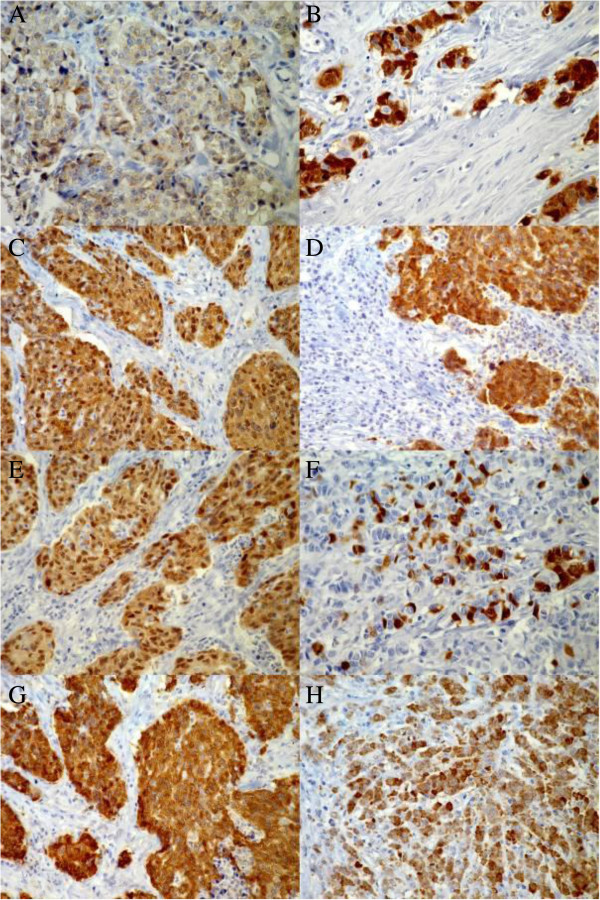
Immunohistochemical detection of cancer - testis antigens and NY-BR-1 in primary breast cancer tissue microarrays. A: Example of moderate staining of MAGE A1 in approximately 80% of the tumor cells. The staining is restricted to the cytoplasm. B: Strong nuclear and cytoplasmic expression of MAGE A1. C: Extensive strong nuclear and cytoplasmic M3H67 immunoreactivity. D: Strong, mainly cytoplasmic and occasionally nuclear 57B immunoreactivity. E: Extensive strong nuclear and cytoplasmic detection of MAGE A (6C1). F: Focal strong, mainly cytoplasmic staining of approximately 20% of tumor cells for GAGE. G: Strong extensive cytoplasmic and occasionally nuclear staining of NY-ESO-1. H: Strong cytoplasmic NY-BR-1 staining of approximately 80% of cells with scarce nuclear detection (40x objective).